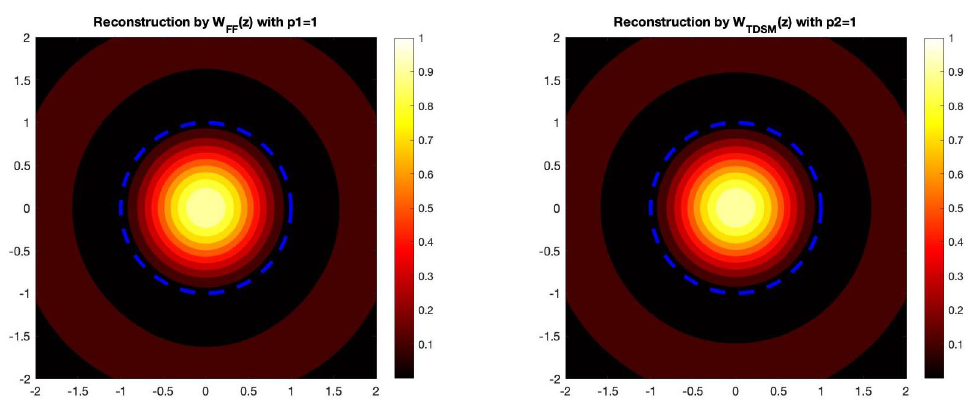
Figure 10. The reconstruction of the unit sphere by the direct sampling imaging functionals. In this example, we take δ = 0.05, which corresponds to a 5% noise